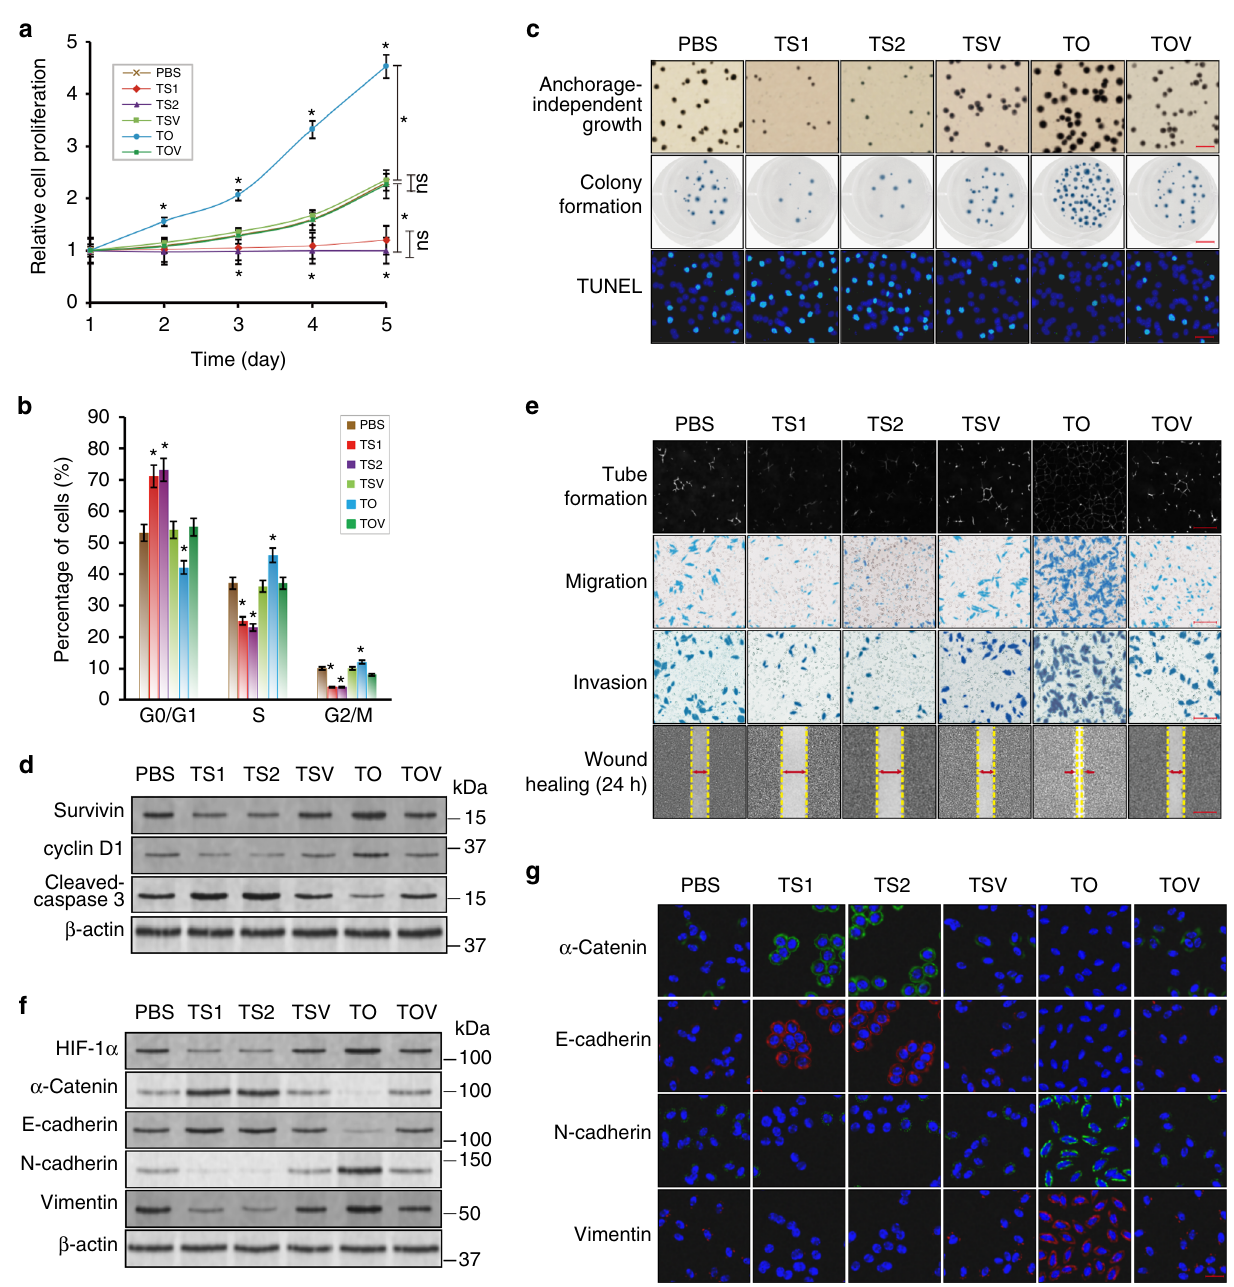
Fig. 3 The relationship between PBOV1 expression level and Hep3B cell growth/metastasis property in vitro. a Hep3B cell growth rates determined by MTT assay. b Hep3B cell cycle analysis by fl ow cytometry assay. c Cell proliferation re fl ected by anchorage-independent growth assay ( fi rst panel, top down; Scale bar, 1 mm), cell colony formation assay (second panel, top down; Scale bar, 10 mm), and terminal deoxynucleotidyl transferase-mediated dUTP nick end labeling assay (TUNEL) cell apoptosis assay (third panel, top down; Scale bar, 20 μ m) (assay; Blue, DAPI-indicating nuclei; green, FITC indicating apoptotic nuclei). d Protein expression levels of survivin, cyclin D1, and cleaved-caspase 3 determined by western blotting assay. e Tube formation assay by human liver tumor endothelial cells (SK-Hep1) cultured on Matrigel-coated plates with conditioned media collected from the Hep3B cell incubation ( fi rst panel, top down; Scale bar, 100 μ m). Hep3B cell migration ability determined by transwell migration assay (second panel, top down; Scale bar, 50 μ m). Hep3B cell invasion ability determined by transwell invasion assay (third panel, top down; Scale bar, 50 μ m). Hep3B cell mobility measured by testing the rate of wound healing at 24 h after serum starvation and wound creation (fourth panel, top down; Scale bar, 500 μ m) (See also Supplementary Fig. 5b). f Protein expression levels of angiogenesis marker HIF-1 α , epithelial markers α -Catenin and E-cadherin, and mesenchymal markers N-cadherin and Vimentin determined by western blotting assay. g Immuno fl uorescence assays for epithelial markers α -Catenin and E-cadherin, and mesenchymal markers N- cadherin and Vimentin. Scale bar, 20 μ m (Blue, DAPI-indicating nuclei; green, FITC indicating α -Catenin or N-cadherin protein; red, Cy5 indicating E- cadherin or Vimentin protein). (See also Supplementary Fig. 5d). Data were represented as means ± S.D. Error bars represent the S.D. values ( n = 3; * P